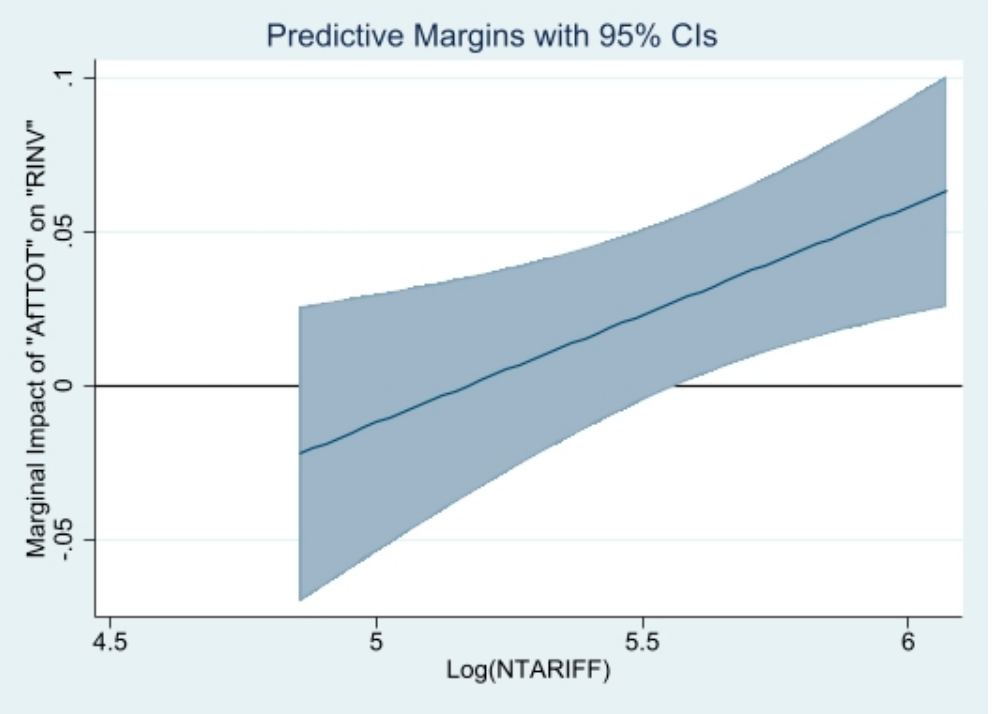
Figure 8. Marginal impact of “AfTTOT” on “RINV” for varying levels of nontariff costs. Source: Author.